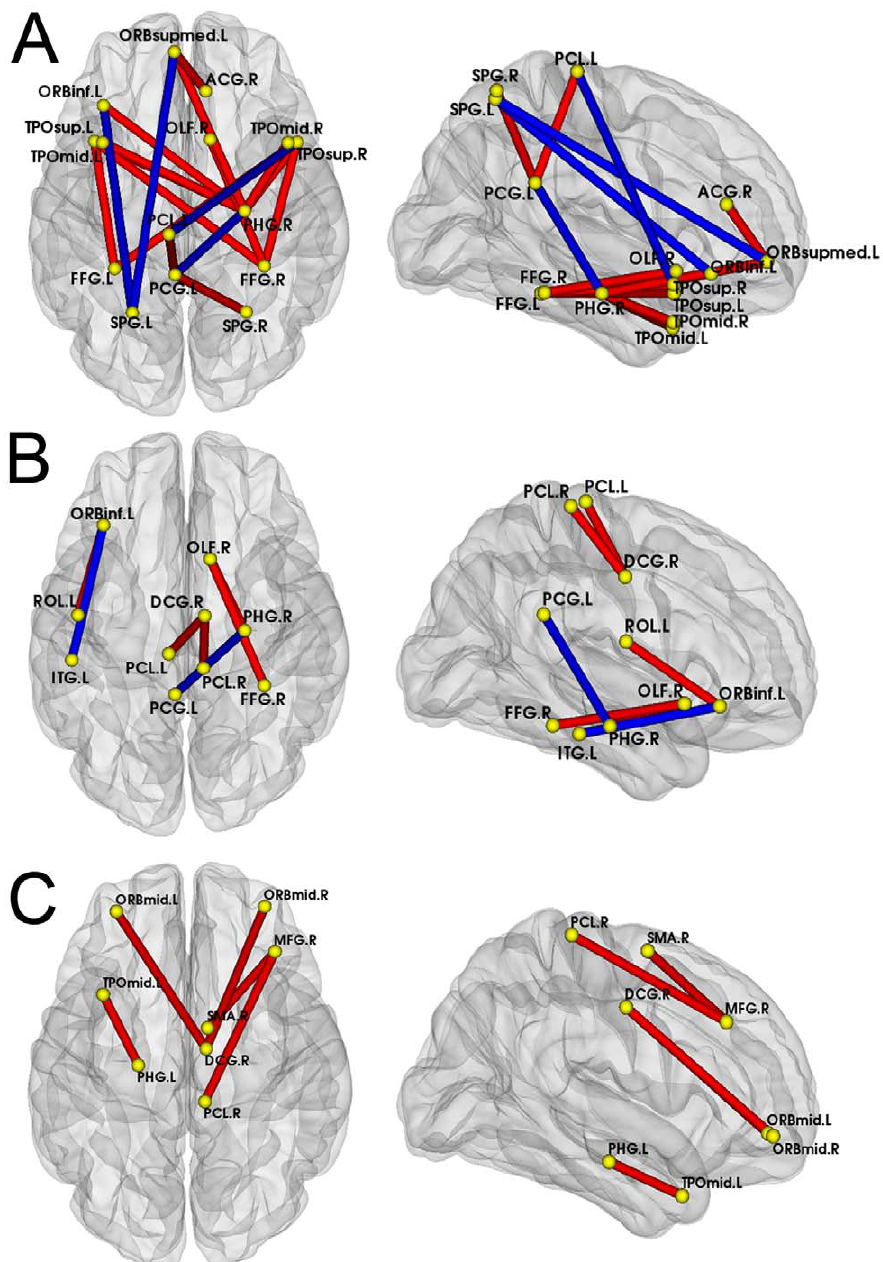
Figure 6. Abnormal interregional correlations in the MCI and AD subjects. The red and blue lines indicate significant between-group differences in interregional correlations between pairs of regions (p , 0.01, FDR-corrected); the yellow dots represent those AAL regions with significantly abnormal correlations. The red and blue lines indicate the significantly increased and decreased interregional correlations between the corresponding regions, respectively. A - Significant changes in interregional correlations between the NC and AD groups. B - Significant changes in interregional correlations between the NC and MCI groups. C - Significant changes in interregional correlations between the MCI and AD groups. For the abbreviations of the regions, see Table 2. may indicate that the disappearance of these hub regions disrupted the large-scale connections between pairs of brain regions [19,46].